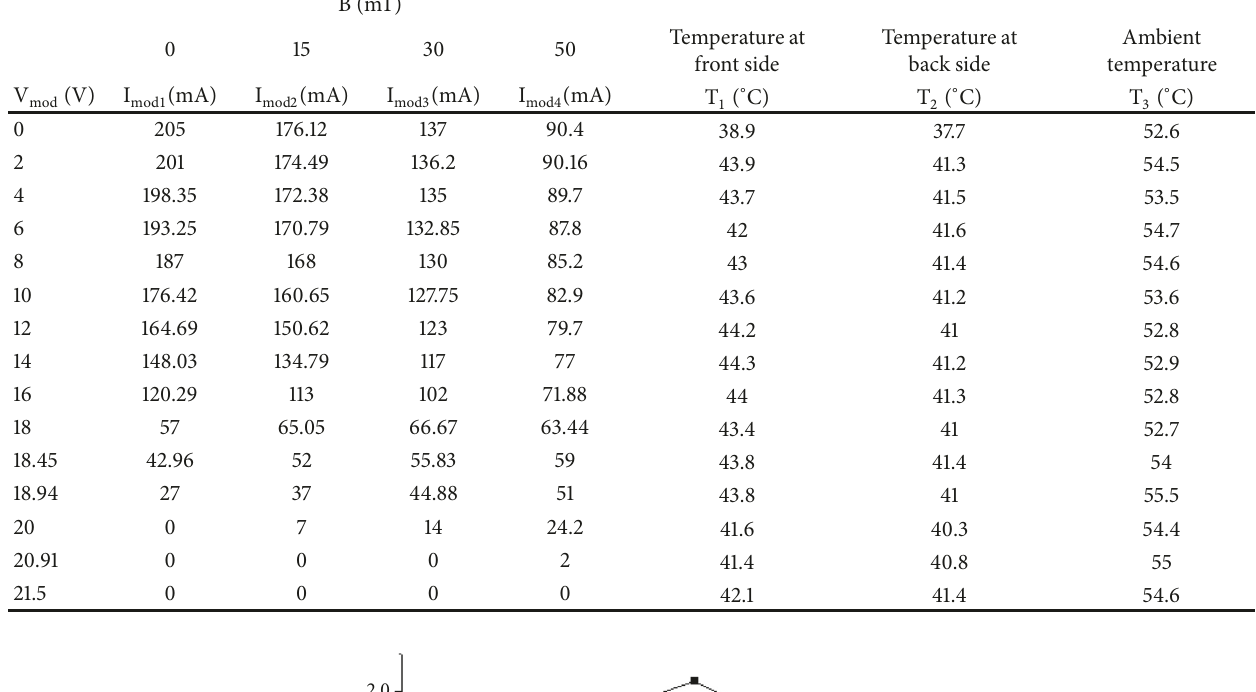
Table 2: Values of current and voltage of the photovoltaic module against the intensity of the magnetic field and for a solar irradiance of 600 W/m 2 .